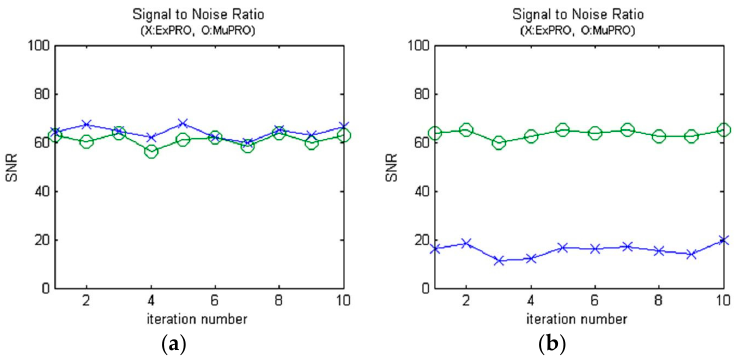
Figure 9. Signal-to-noise ratio. ( a ) Sampling 1/10 s, α = − 0.1; and ( b ) sampling 1/60 s, α = − 0.01.